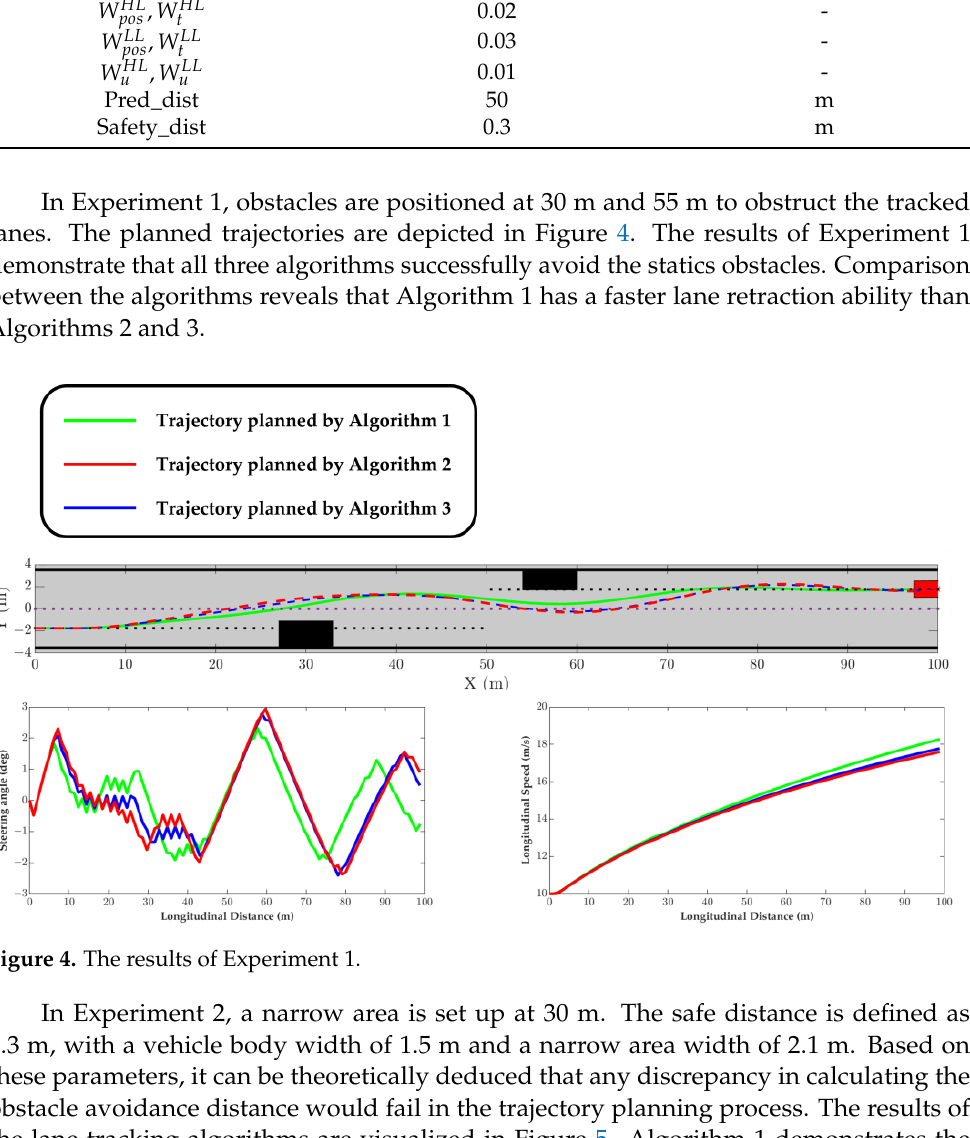
Figure 5. The results of Experiment 2. Experiments conducted in static scenes demonstrate that Algorithm 1 can plan tra- jectories closer to the lane, owing to its non-approximation-based method for obstacle avoidance. This results in more accurate tracking of the original lane. Additionally, Algo- rithm 1 utilizes a double-layer structure, with the lower layer MPC tracking the replanned trajectory. This design contributes to the stability of the algorithm.